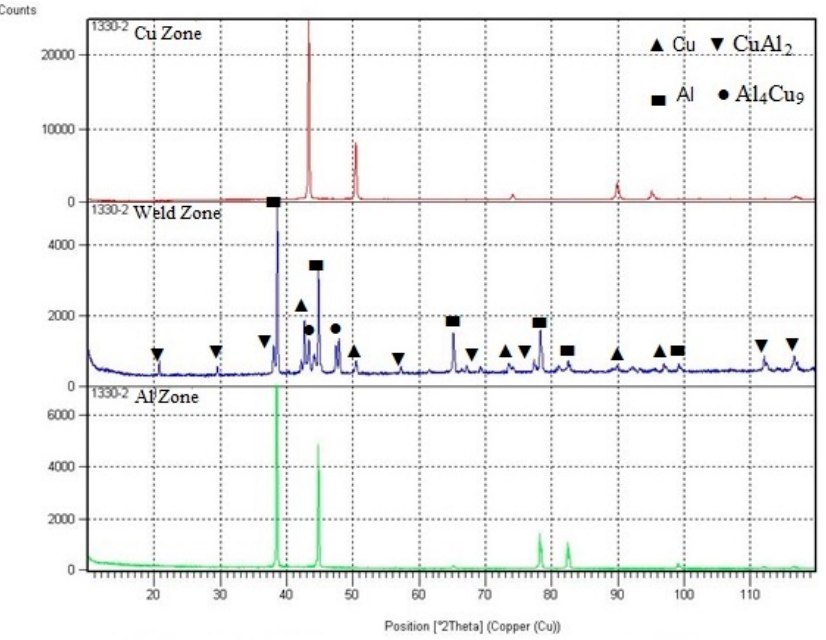
Figure 21. X ‐ ray diffraction (XRD) graphs of base materials and weld zone.